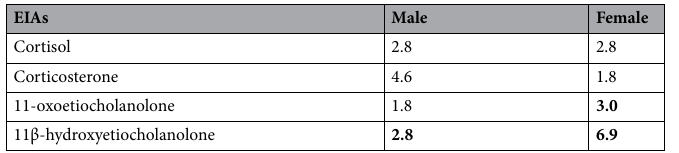
Table 3. Increase in FGMs (in folds) compared with baseline measured using four EIAs in response to anesthesia stimulation in both sexes. Numbers in bold indicate that the EIA was considered suitable for monitoring adrenocortical activity in a specific sex of Formosan macaques. The suitability evaluation was based on the study by Heistermann et al. 30 .